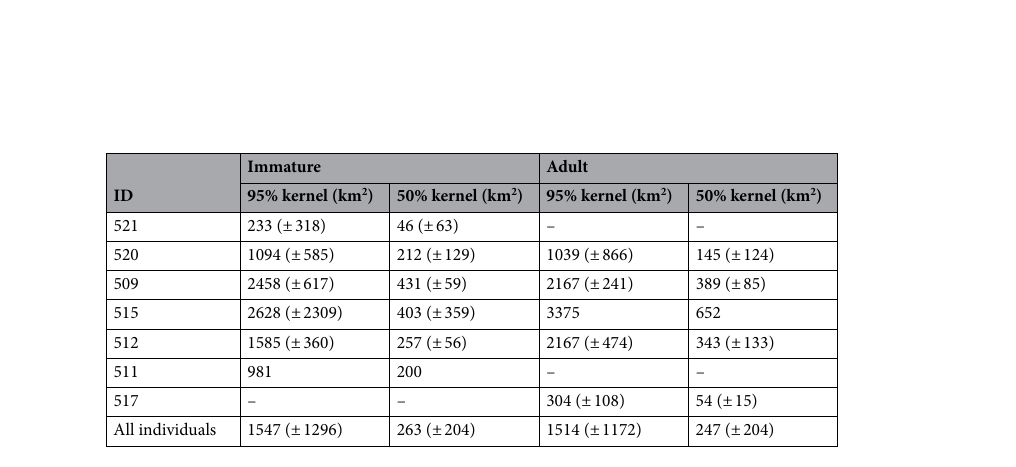
Table 2. Individual average annual home range area (in km 2 ± standard deviation) and total average home range of immature and adult Shoebills, estimated as the 95% and 50% kernel, based on the GPS tracking periods indicated in Table 1.